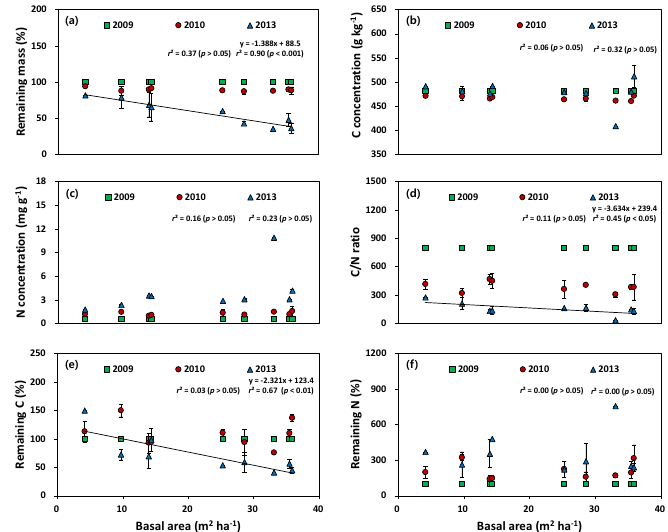
Figure 5. Relationships between basal area and decomposition of branches [( a ) remaining mass, ( b ) carbon and ( c ) nitrogen concentration, ( d ) C/N ratio, ( e ) remaining C and ( f ) N] in pine wilt disease disturbed stands ( n = 3). Vertical bars represent standard error.